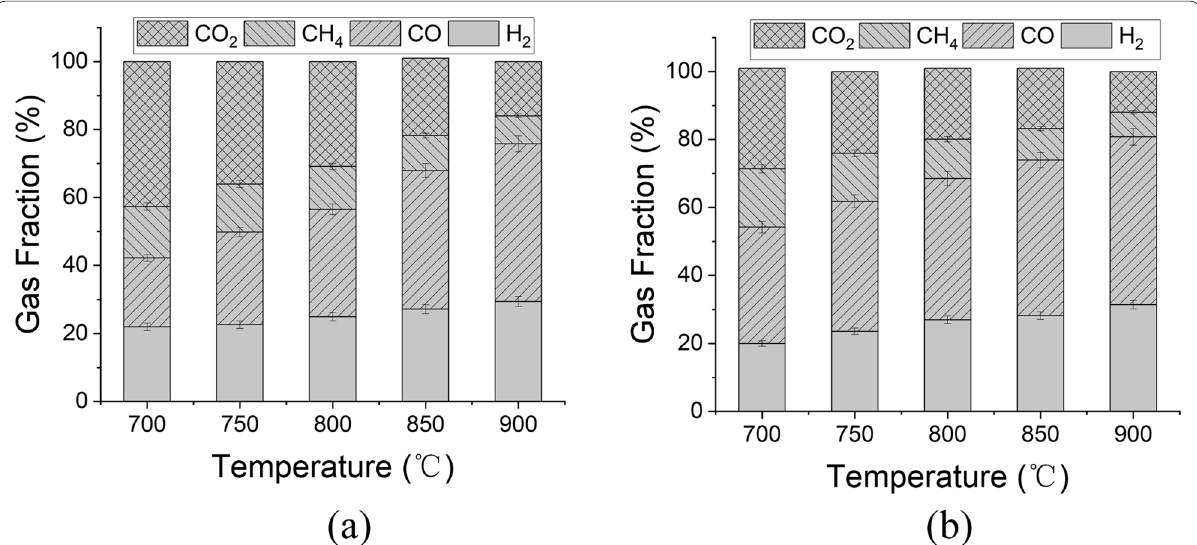
Fig. 3 Effect of gasification temperature on the composition of the gas product. (Reaction Time b supercritical carbon dioxide atmosphere